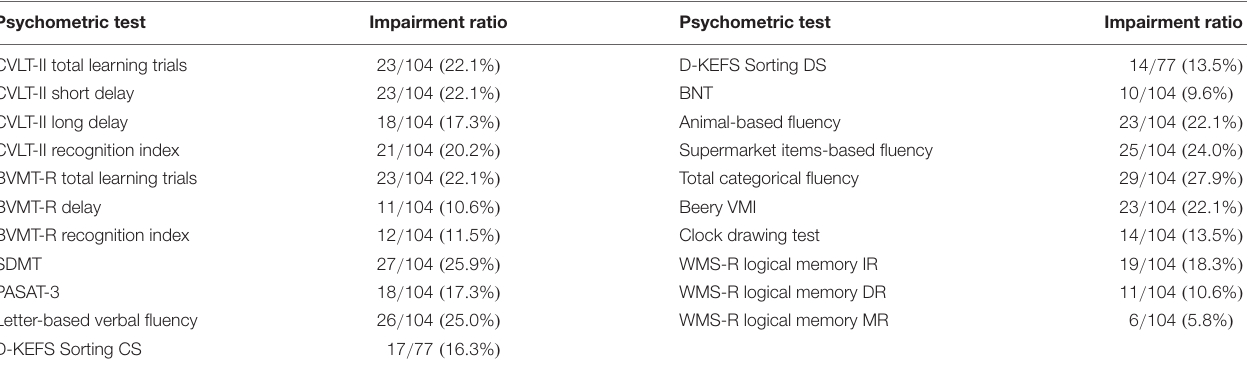
TABLE 4 | The ratio and percentage of cognitive impairment in the EwMS